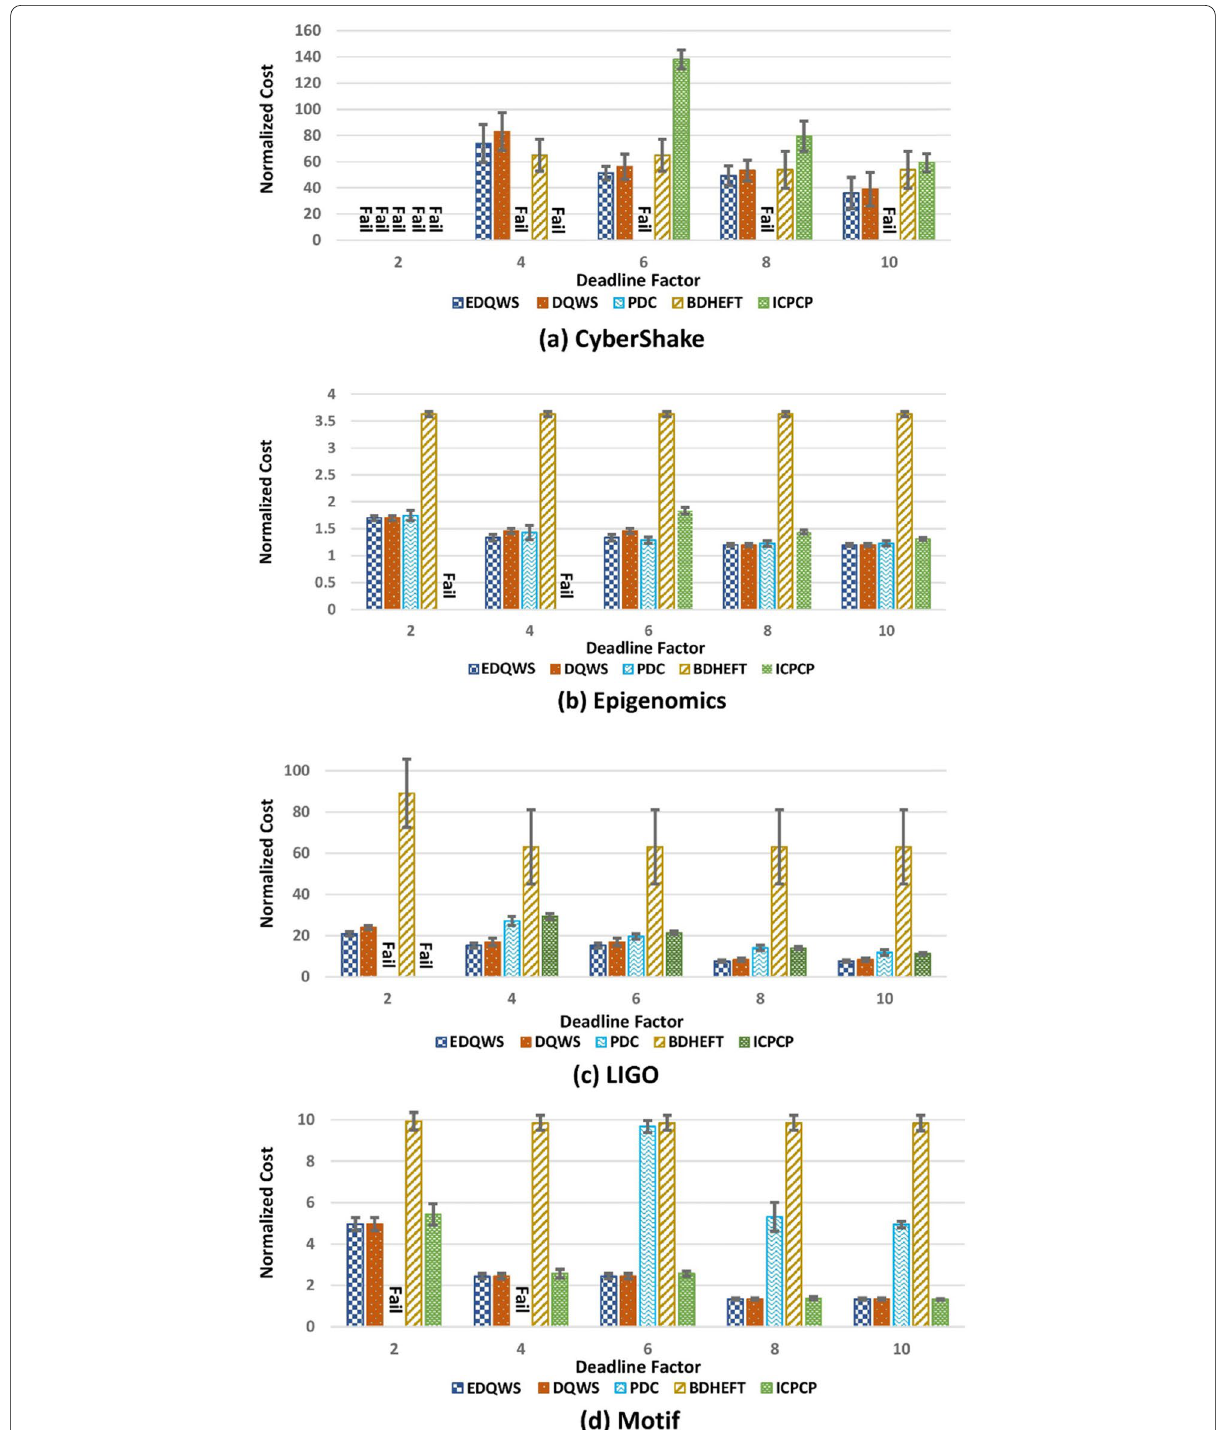
Fig. 11 Normalized Cost vs. Deadline Factor for four different workflow sets (PDC was unable to schedule the CyberShake workflow). Note: the error bar indicates the standard